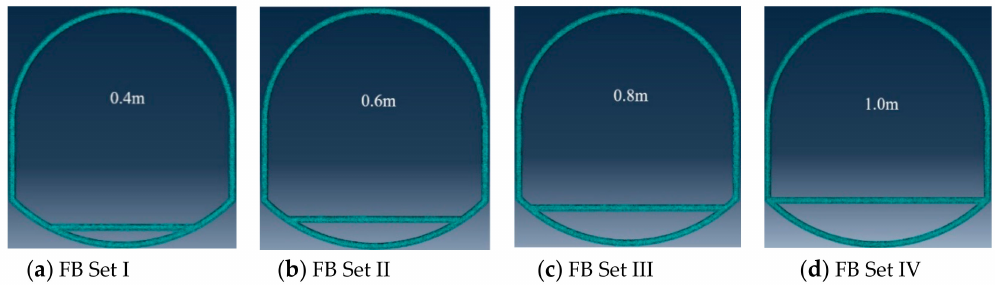
Figure 7. Models of the roof beam (the RB sets).